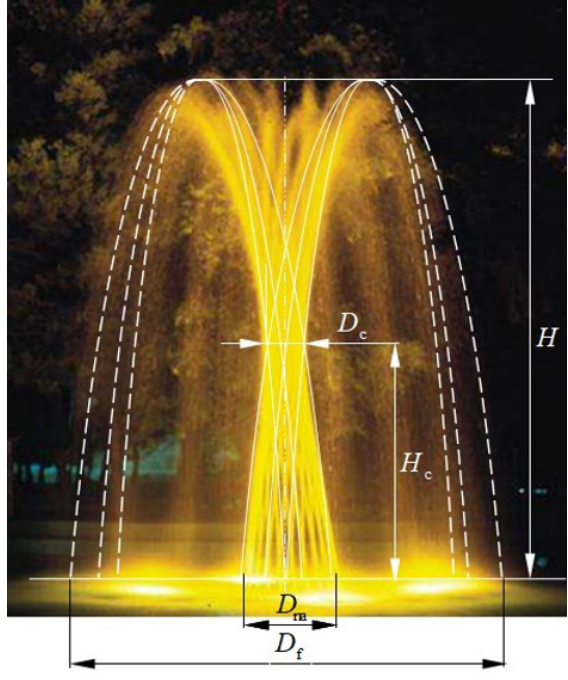
Fig. 1. Basic geometric parameters of the designed